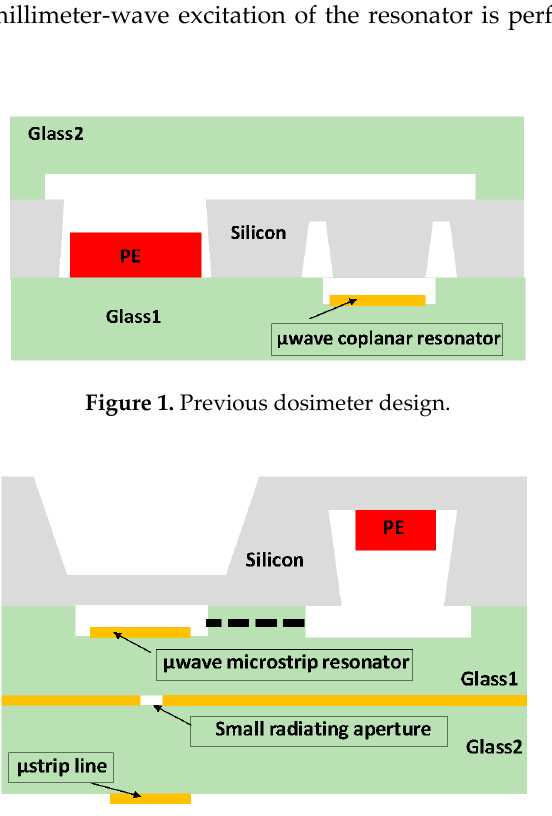
Figure 2. New dosimeter design.